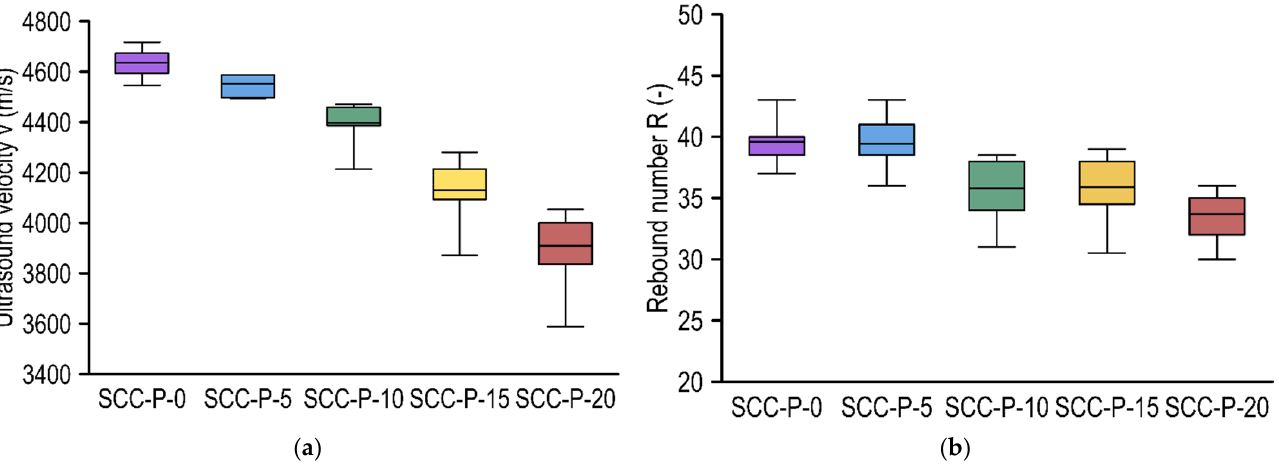
Figure 5. Non-destructive test results: ( a ) ultrasound velocity v and ( b ) rebound number R.